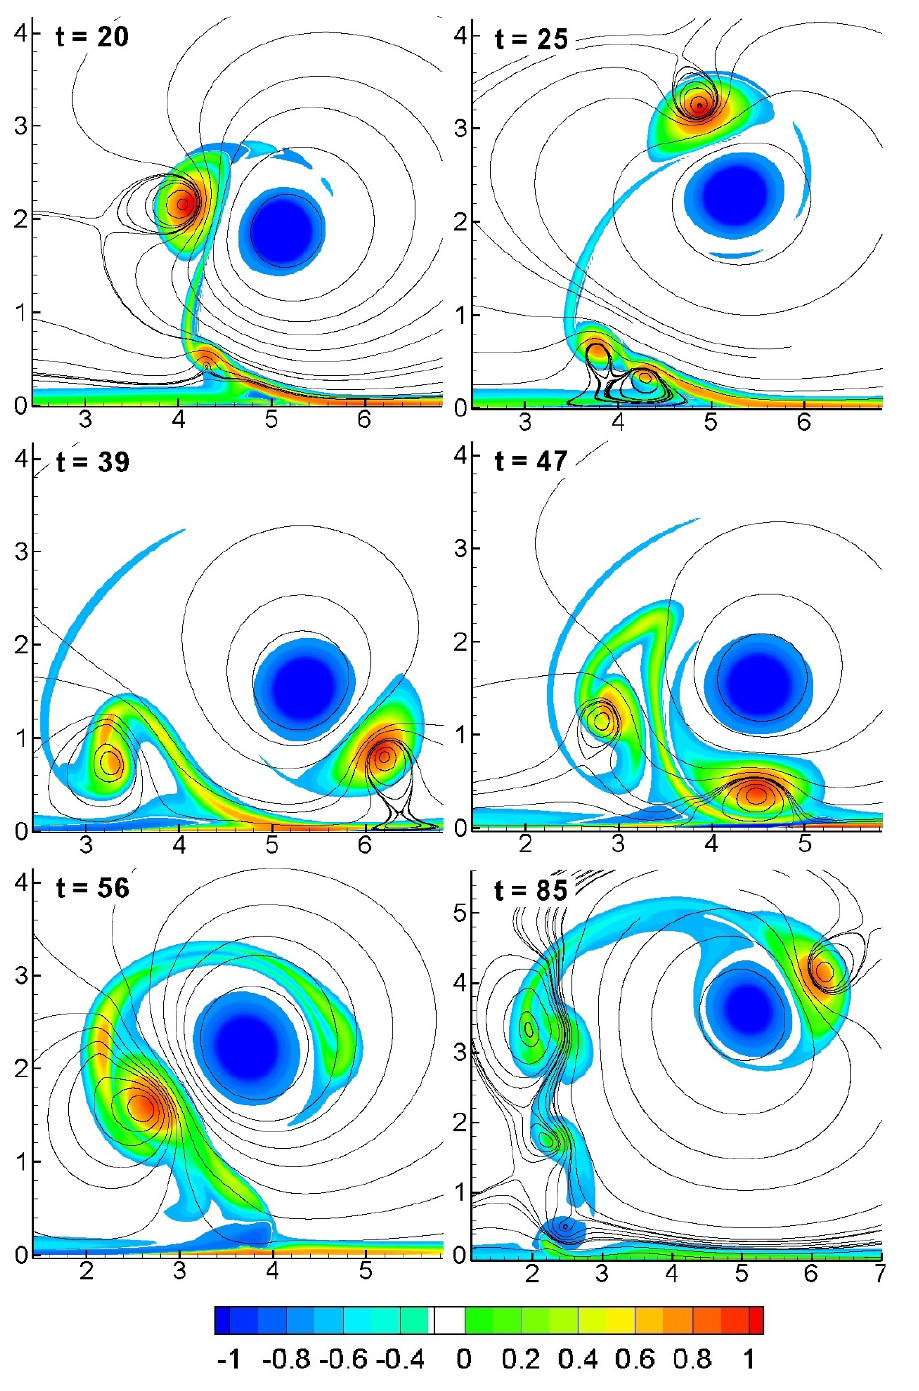
Figure 8. The considered flow for, Re